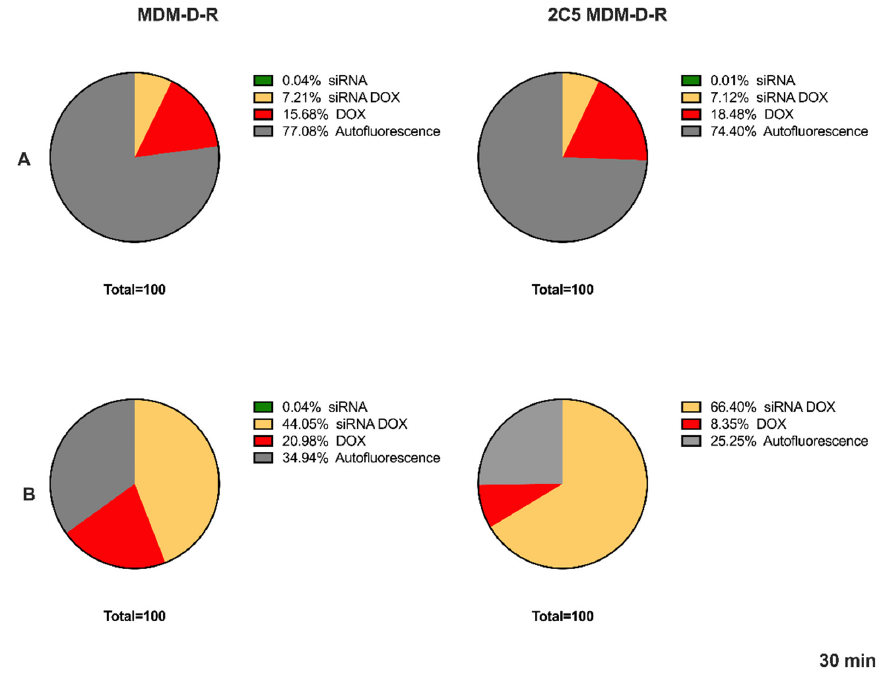
Figure 4. Cellular update data using FACS after 30 min of treatment, ( A ) Skov-3TR and ( B ) MDA-MB-231.